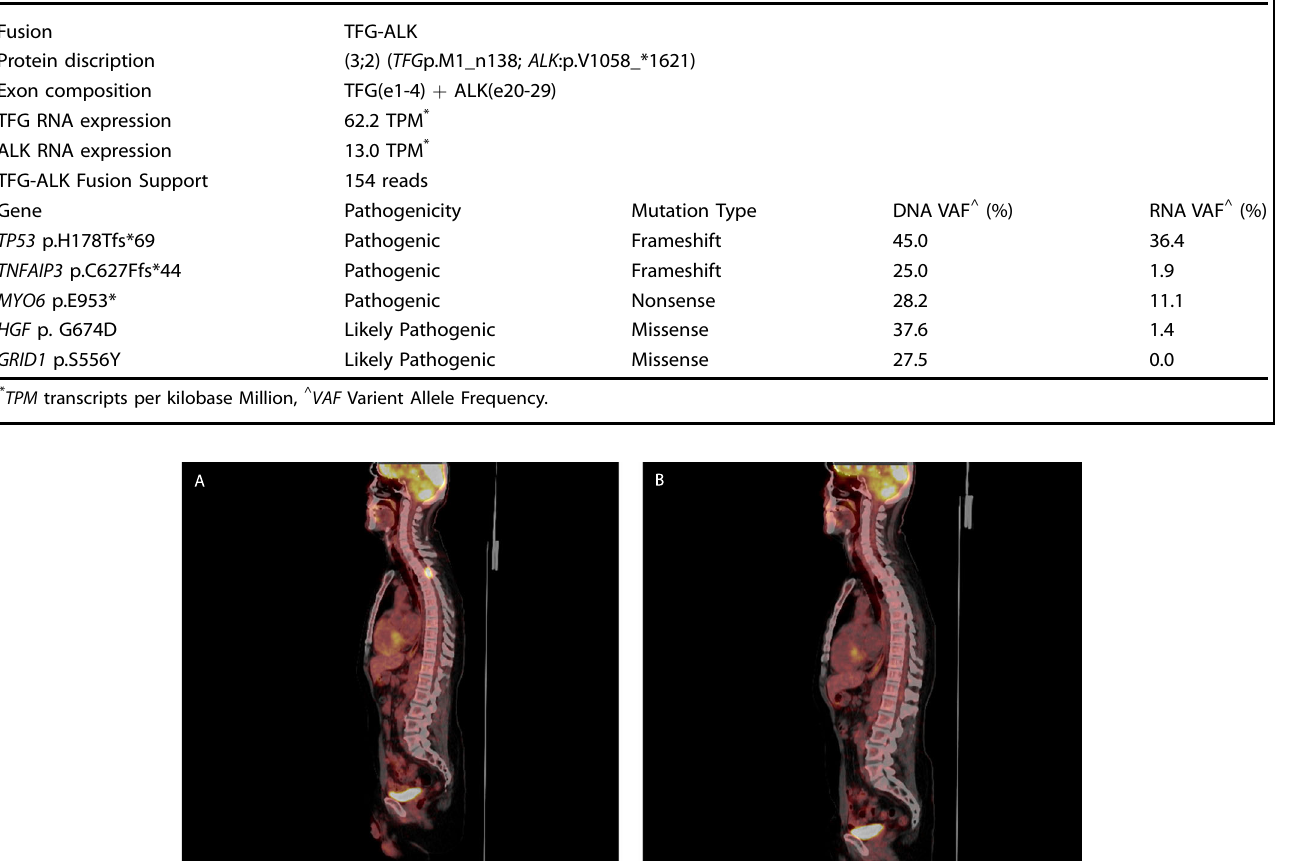
Table 1. Genomic characteristics of TFG-ALK fusion and pathologic gene signature of liver biopsy.